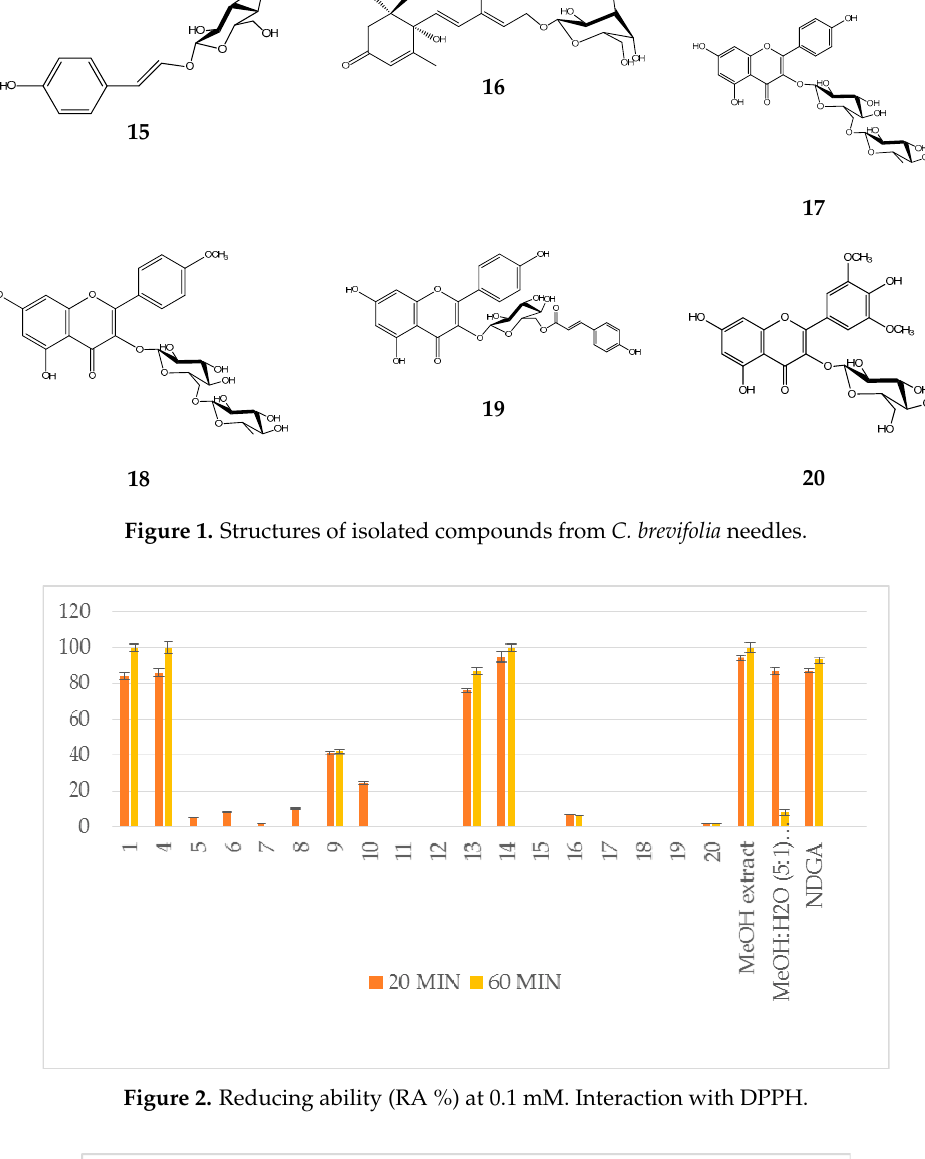
Figure 4. Percent inhibition of lipid peroxidation induced by AAPH at 0.1 mM. Table 1. In vitro reducing ability (RA %) in DPPH assay, soybean lipoxygenase inhibition ( % LOX inhbt) and anti-lipid peroxidation activity (A-LP %). Compound